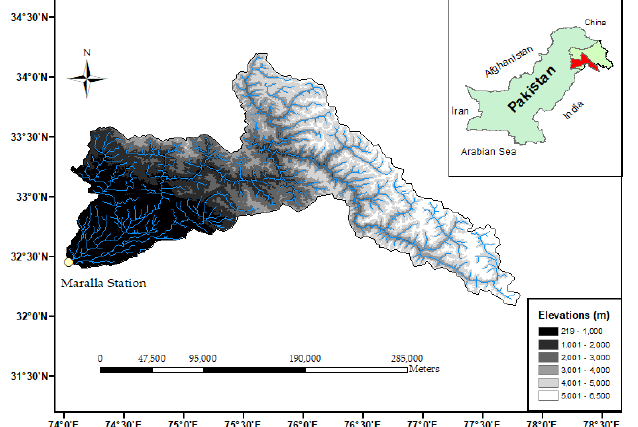
Fig. 4. Location and digital elevation model of Chenab river basin up to Maralla station